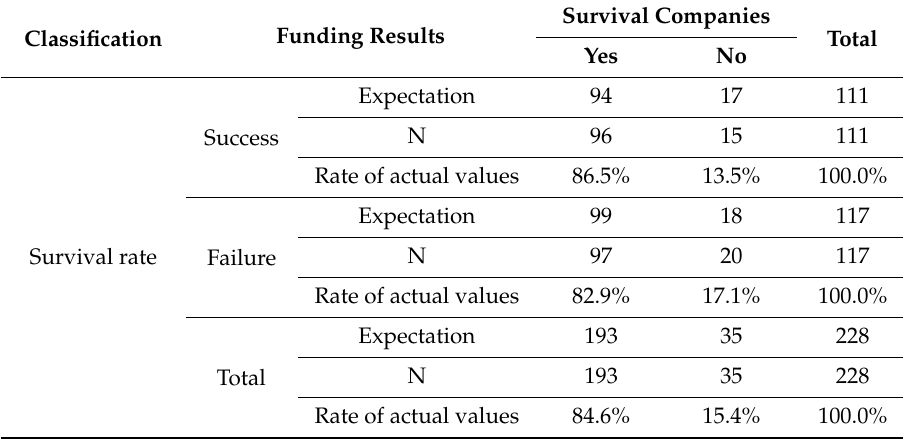
Table 5. Descriptive statistics for survival